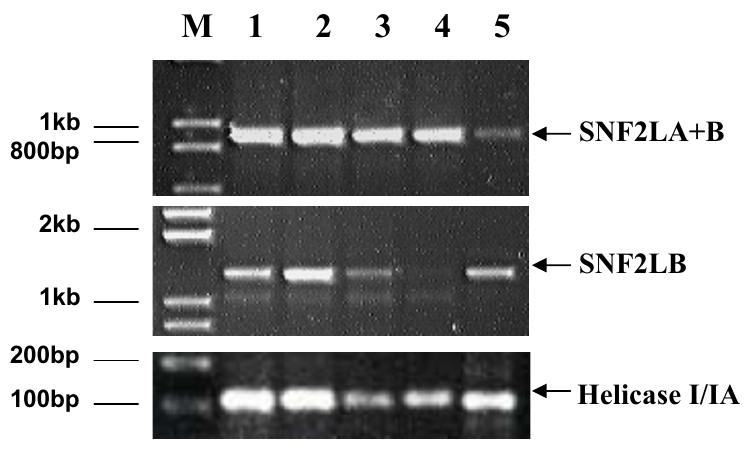
Figure 1 Genomic organization and 5' transcript variants of the human SNF2L gene . A . Schematic diagram showing the 25 exons (dark boxes; exon 13 is an open box) of the human SNF2L gene (top). Below is a schematic diagram of the SNF2L tran- script showing the ORF (open box) and the location of the motifs that comprise the SNF2 domain (blue boxes) and the SANT domains (red boxes). B . The 5' variants SNF2LA and SNF2L B provide alternative initiation codons and encode two forms of SNF2L with different amino-termini. They are shown aligned to the mouse Snf2l sequence. The SNF2L B transcript encodes a protein with an amino-terminus similar in length and amino acid composition to the murine Snf2l protein. C . RT-PCR analysis showing that both transcript variants are present in human cell lines and fetal brain tissue examined. The helicase I/Ia domain served as control amplification. Lane 1, 293 cells; lane 2, SH-SY5Y cells; lane 3, NT2 cells; lane 4, hNT neurons; and lane 5, human fetal brain. M, molecular weight